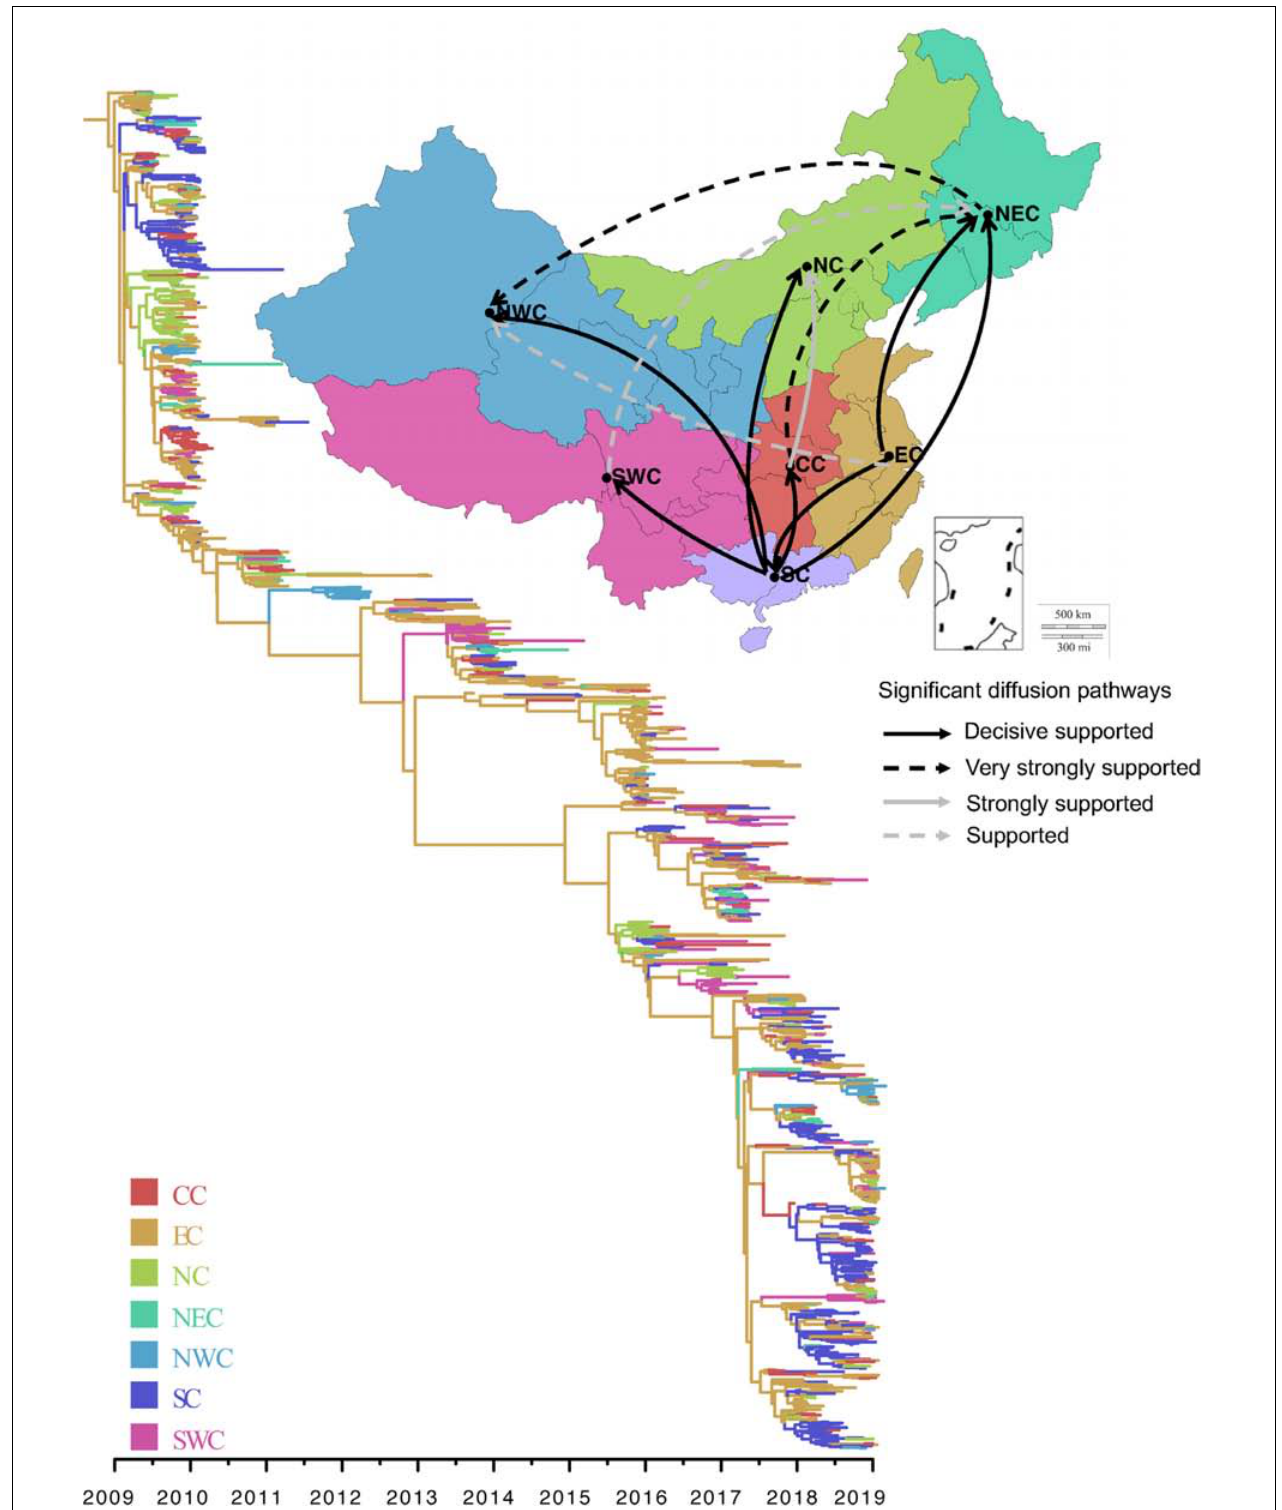
FIGURE 7 | Spatial diffusion of A/H1N1pdm virus. Thickness of lines represents supported migration rates: solid black arrows, decisive support with BF > 1000; dashed black arrows, very strongly supported with 100 < BF < 1000; solid gray arrows, strongly support with 10 < BF < 100; dashed gray arrows, support with 3 < BF < 10. In the phylogenetic tree, colored branches represent different regions. North China (NC), Northeast China (NEC), Northwest China (NWC), Central China (CC), East China (EC), South China (SC), and Southwest China (SWC).